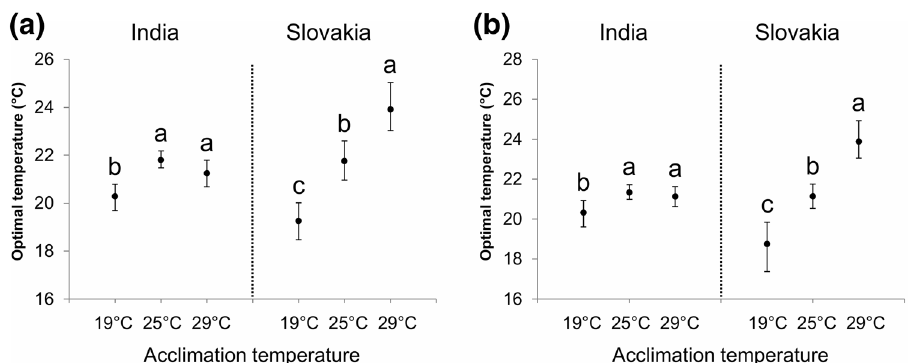
Figure 4. The optimal temperatures for glycogen stores estimated based on ( a ) the absolute glycogen content (µg glycogen per fly), and ( b ) the relative changes in the absolute glycogen content. Error bars represent 95% confidence intervals. Values with different letters are significantly different from each other (α =